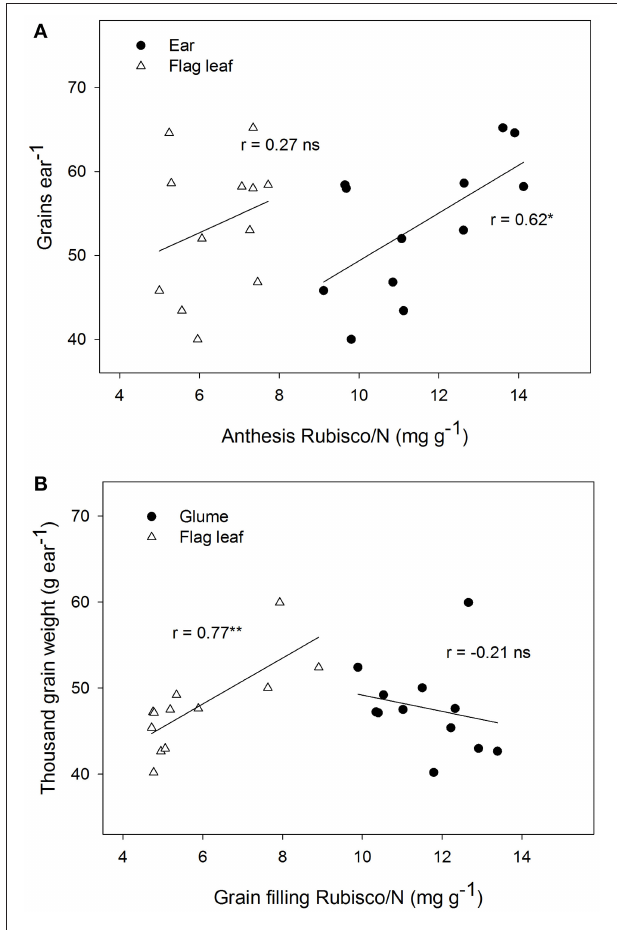
FIGURE 3 | Linear correlations of grain number per ear (grains ear − 1 ) with Rubisco content per unit of total nitrogen in the flag leaves and ears at anthesis (A) , and thousand grain weight (TGW) with Rubisco content per unit of total nitrogen in the leaves and ears during grain filling (B) for four Chinese winter wheat genotypes. (* P < 0.05; ** P < 0.01; ns, not